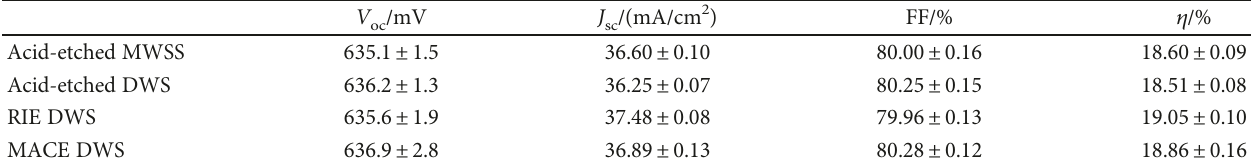
Table 1: Electrical performance of mc-Si solar cells with di ff erent surface structure. V oc